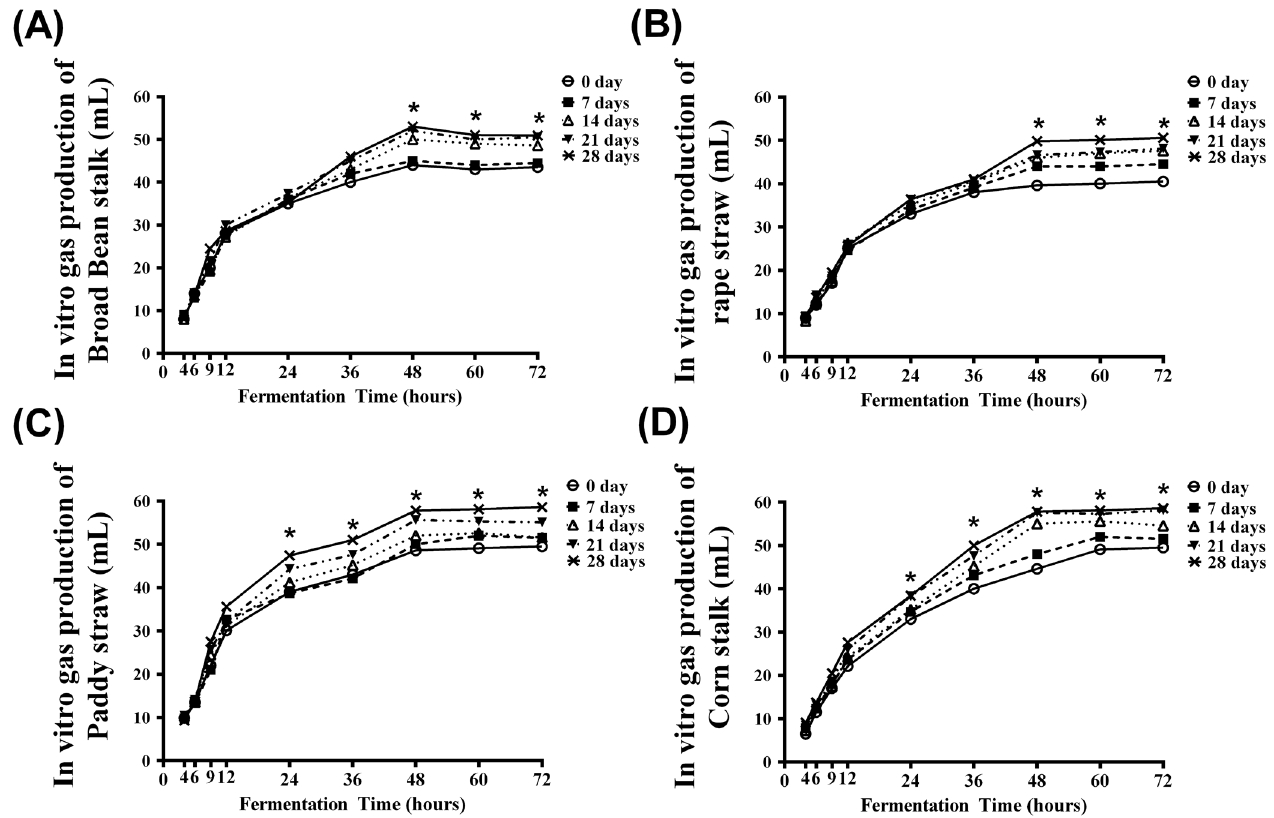
Figure 2. In vitro ruminal fermentation of stalks cultured with Pleurotus ostreatus for 0, 7, 14, 21, and 28 day of co-culturing time. (A) In vitro gas production of broad bean stalk degraded by Pleurotus ostreatus for different time; (B) In vitro gas production of rape straw degraded by Pleurotus ostreatus for different time; (C) In vitro gas production of paddy straw degraded by Pleurotus ostreatus for different time; (D) In vitro gas production of corn stalk degraded by Pleurotus ostreatus for different time. The symbolic of * indicates significant different